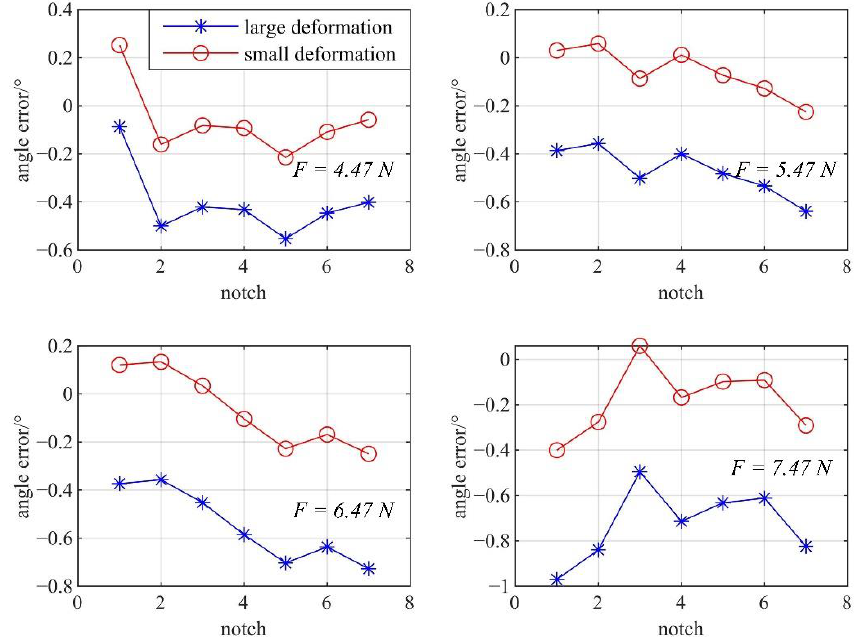
Figure 13. Bending angle error of every single notch under different forces.